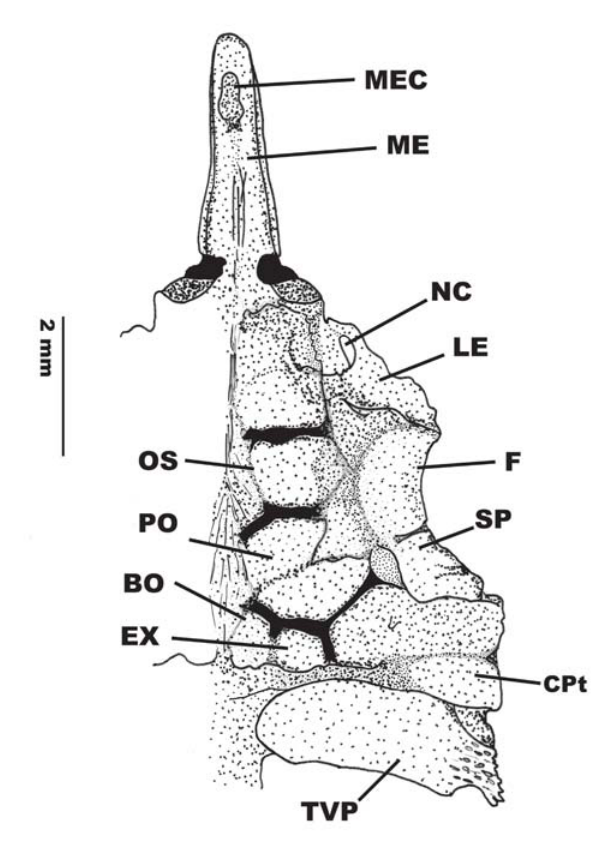
Fig. 5. Left side of neurocranium in ventral view of Gymnotocinclus anosteos , MCP 41726, paratype, male, 40.5 mm.